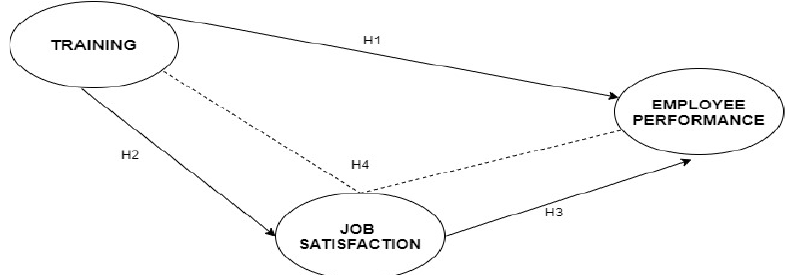
Figure 1: Research model; Source: Authors